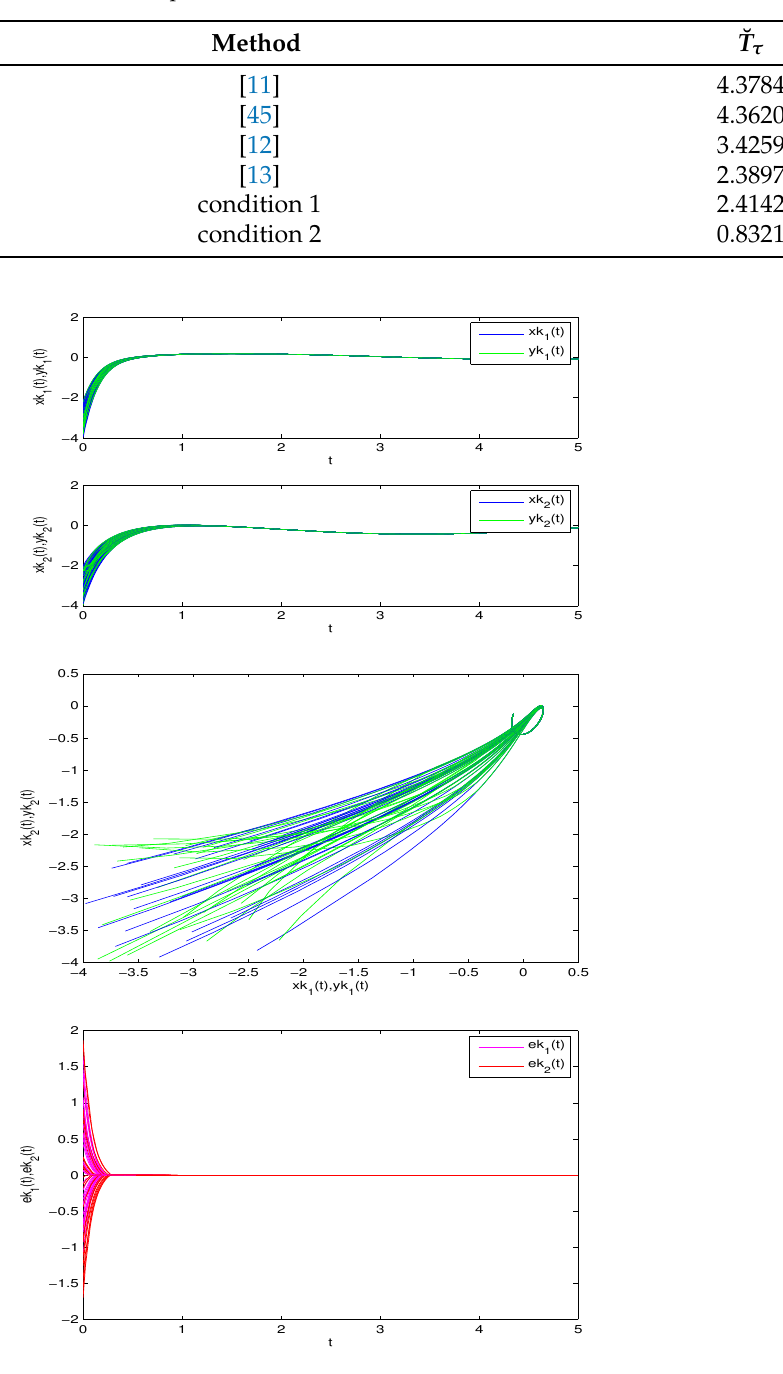
Figure 8. Instantaneous error states for the K part between for the variable ˘ x of (18) and ˘ y of (19) under 30 random initial values for fixed-time